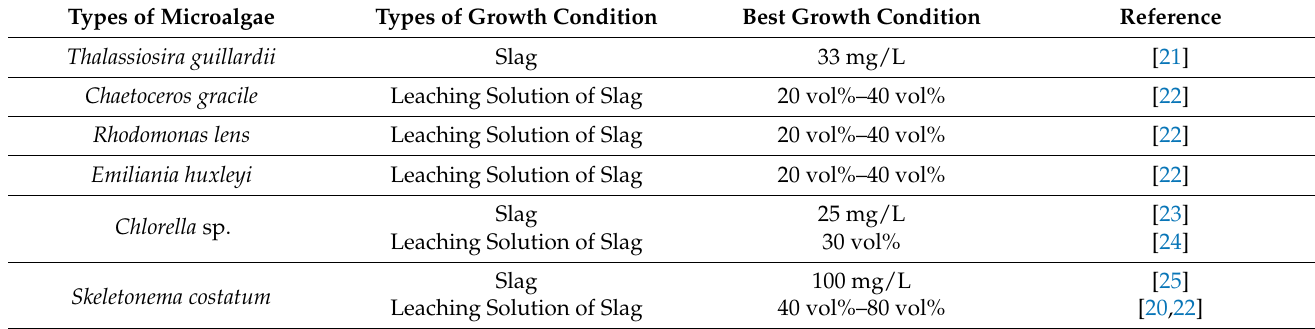
Table 1. The best growth condition of